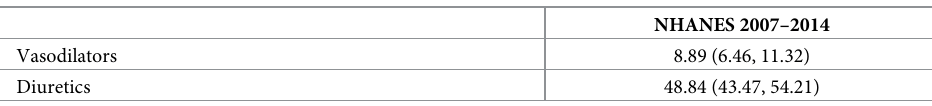
HF = heart failure; CI = confidence interval; ACEI = angiotensin converting enzyme inhibitor; ARBNI = angiotensin II receptor blocker neprilysin inhibitor Values the percentage (95% CI) unless otherwise specified. a the weighted proportion of the individuals with HF among the US adults b walking difficulty score is an average score of the three self-reported questions with 4-points Likert type scale.